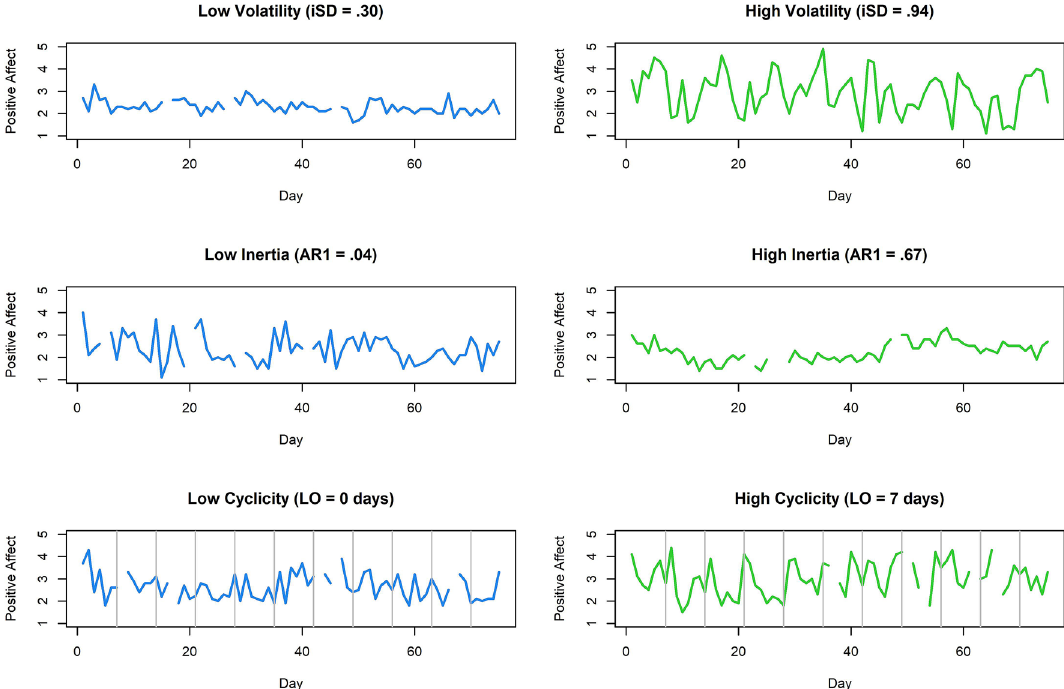
Figure 1. Example 75-day time series plots for participants who had relatively low (< 25th percentile) and relatively high (> 75th percentile) values on positive affective variability indices: Volatility , or intra-individual standard deviation (iSD); Inertia, or the strength of the first order autoregressive relation (AR1); and Cyclicity, or the longest order (LO) between 0 and 7 days for which there was a statistically significant autoregressive relation. Gray lines in plots of Cyclicity indicate every 7th